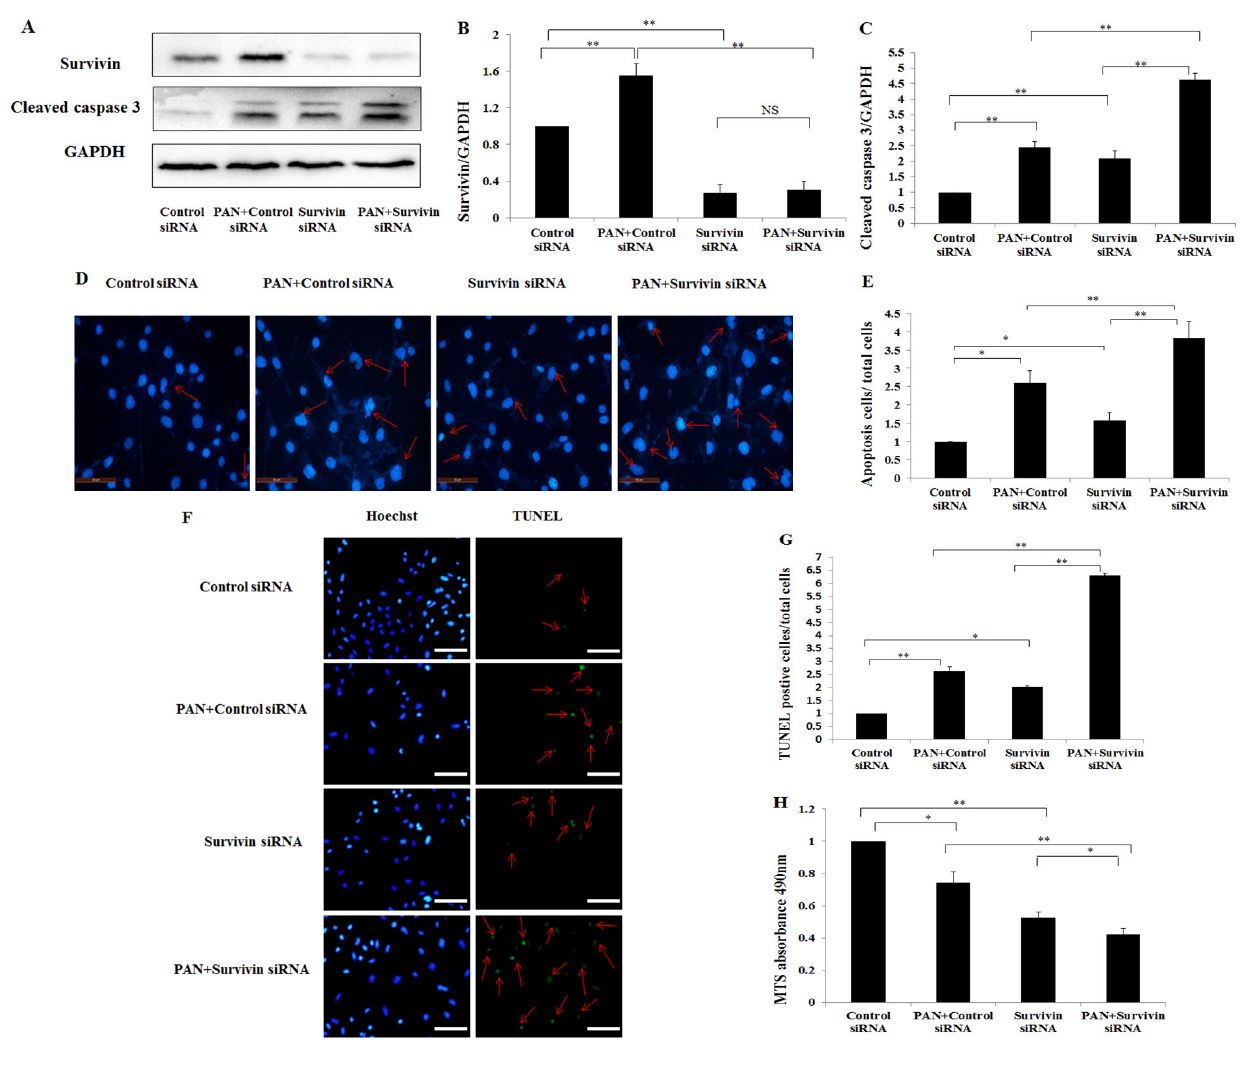
Figure 4. The effect of knocked down survivin on PAN-induced injury of poodcytes. ( A ) Total cell lysates were prepared and analyzed via western blot with antibodies against survivin, cleaved caspase 3 and GAPDH respectively; ( B , C ) The amounts of each protein were quantified and calibrated with the expression of GAPDH; ( D ) Images of podocytes stained with Hoechst (200×, original magnification). Hoechst staining shows nuclei of apoptosis and living cells, Bar = 50 μ m. Red arrows indicate apoptotic cells; ( E ) Quantitative analysis of apoptosis cells presents as apoptosis cells/total cells; ( F ) Images of podocytes stained with TUNEL. Bar = 100 μ m. The green color is indicative of TUNEL-positive cells (indicated with red arrows), and the blue color marks the presence of all cells; ( G ) The percentage of apoptotic cells is reported. For each group in a given experiment, at least 300 randomly chosen cells were analyzed; ( H ) MTS analysis of the rate of podocytes viability; ( I ) F -actin and survivin staining with the fluorescence study demonstrates in red and green, respectively. The double-labelled assays showed that survivin co-localized with F -actin. Bar = 40 μ m. Data are presented as mean ± SD. n = 3. * p < 0.05, ** p < 0.01, NS means no